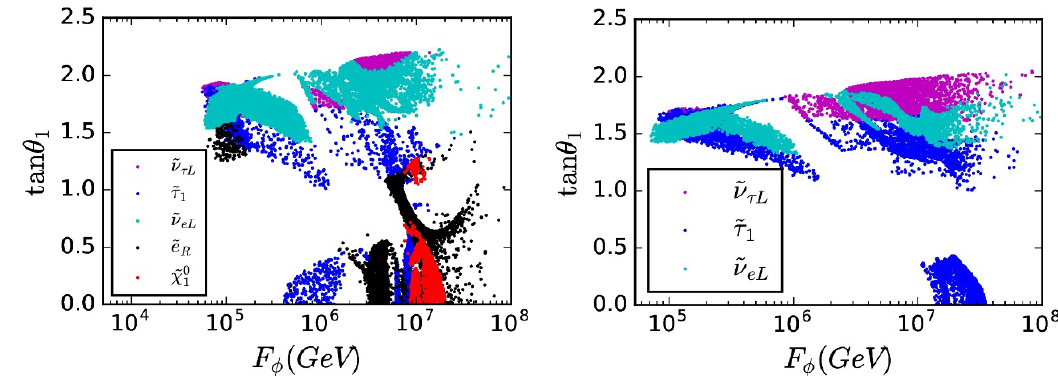
Figure 1 . Allowed regions of tan (cid:18) 1 vs F (cid:30) with a = 3 (left panel) and a = 2 (right panel) in scenario I. All points satisfy the constraints from (I) to